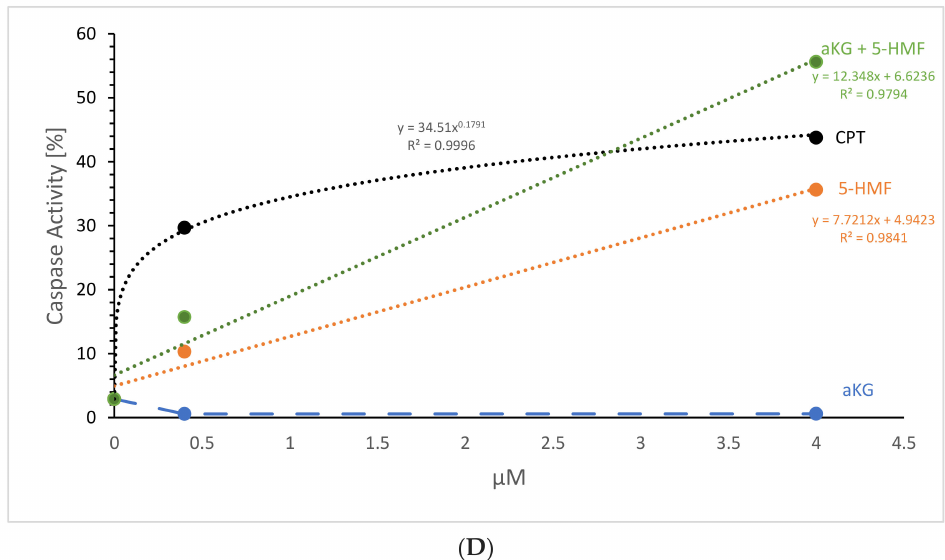
Figure 7. Representative original immunohistoblots of the caspase-activated apoptosis of the Jurkat cell lines using ( A ) 0.4 and 4 µ M CPT, 1.7 µ M aKG + 0.6 µ M 5-HMF and 3.4 µ M aKG + 1.3 µ M 5-HMF; ( B ) 0.4 and 4 µ M CPT, 1.7 and 3.4 µ M aKG, 2 and 4 µ M 5-HMF, caspase activity of 0.4 and 4 µ M CPT, 1.7 and 3.4 µ M aKG, 2 and 4 µ M 5-HMF ( n = 3); ( C ) correlation of caspase-activated apoptosis against different concentrations of aKG, 5-HMF, CPT and combination of aKG + 5-HMF on Jurkat cell lines ( D ). ** p < 0.01: significance between control and 2 or 4 µ g/mL 5-HMF; ## p < 0.01: significance between the control and 1.7 µ M aKG + 0.7 µ M 5-HMF and 3.5 µ M aKG + 1.3 µ M 5-HMF; ◦◦ p < 0.01: significance between 0.7 µ M 5-HMF and 3.5 µ M aKG and 2 µ M 5-HMF; ++ p < 0.01: significance between 3.5 µ M aKG + 1.3 µ M 5-HMF and 4 µ M